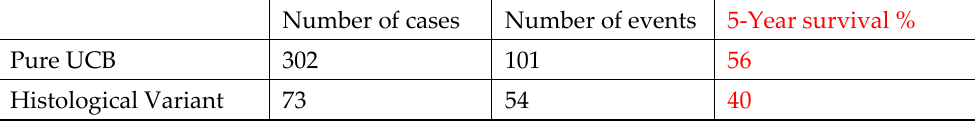
Figure 1. Kaplan–Meier analysis assessing recurrence-free survival ( A ), CSM-free rates ( B ) and OM-free rates ( C ) after RC, stratified by histology.